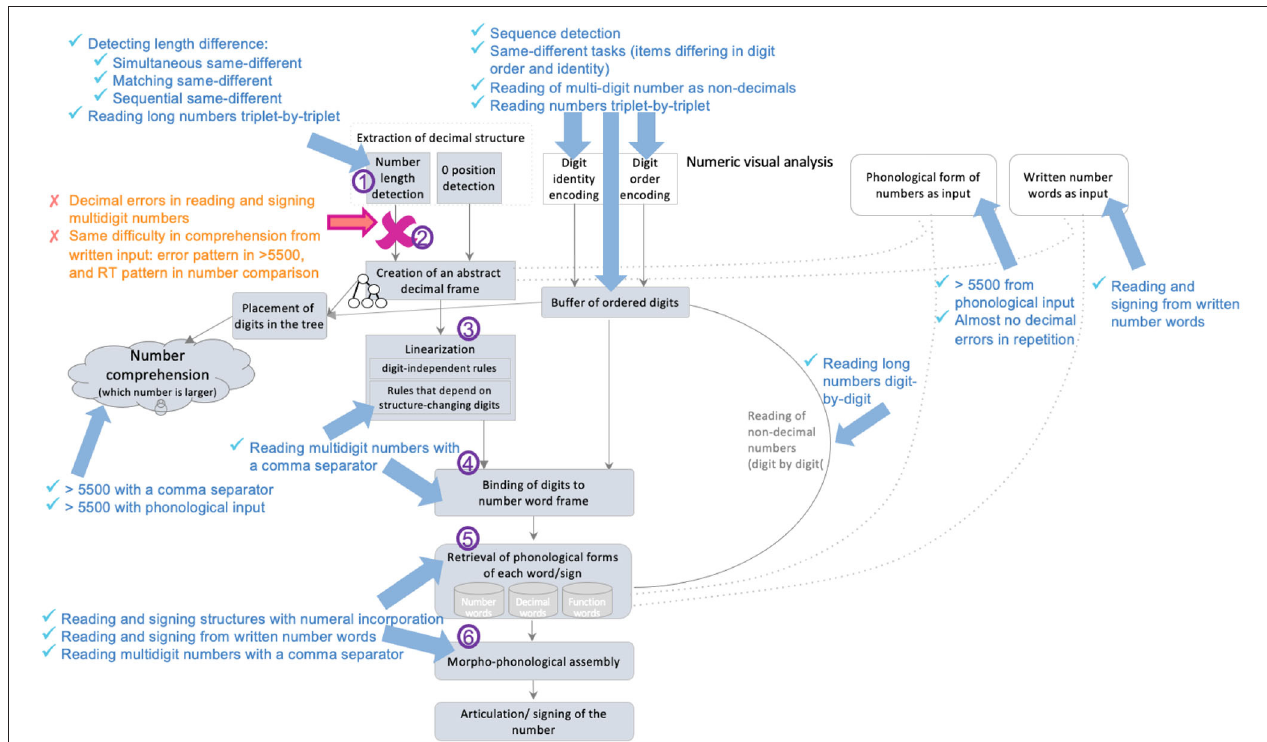
FIGURE 7 | The number reading model with Nomi’s performance related to each of the components. In blue: performance that is within the control range; orange: impaired performance, lower than the control group. Circled numbers indicate theoretically possible sources of decimal errors in multidigit number reading. Crimson X indicates the locus of Nomi’s deficit in view of her performance in the various